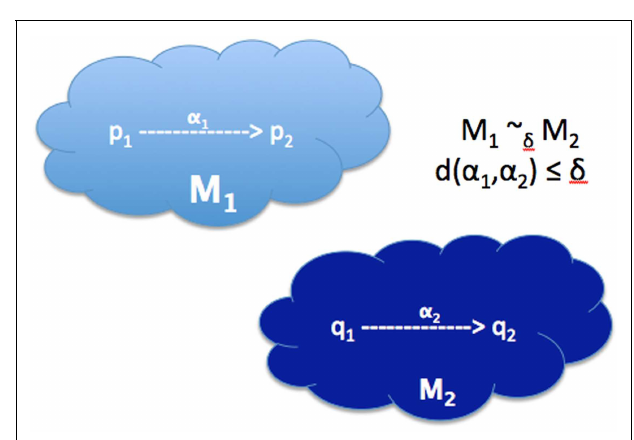
FIGURE 6 |Approximate bisimulation equivalence . α 1 and α 2 are trajectories of simulations in M 1 and M 2 , respectively. d( α 1 , α 2 ) is the distance metric between the